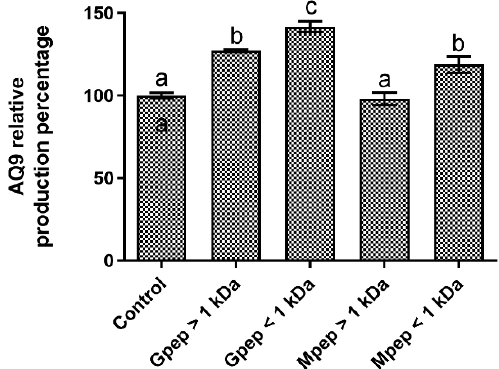
Figure 9. Aquaporin-9 relative percentage of production in the presence of different peptide fractions relative to the basal level (control). Different letters represent the statistically significant differences ( p < 0.05) found between the samples tested.